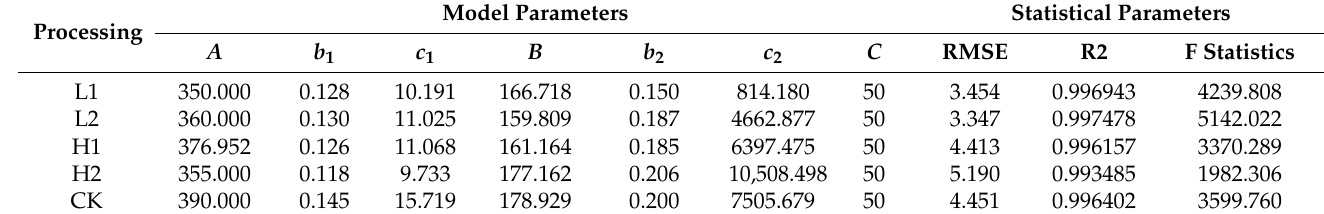
Table 3. Fitting results of the basic kinetic model for water level management rice stem tiller dynamics.